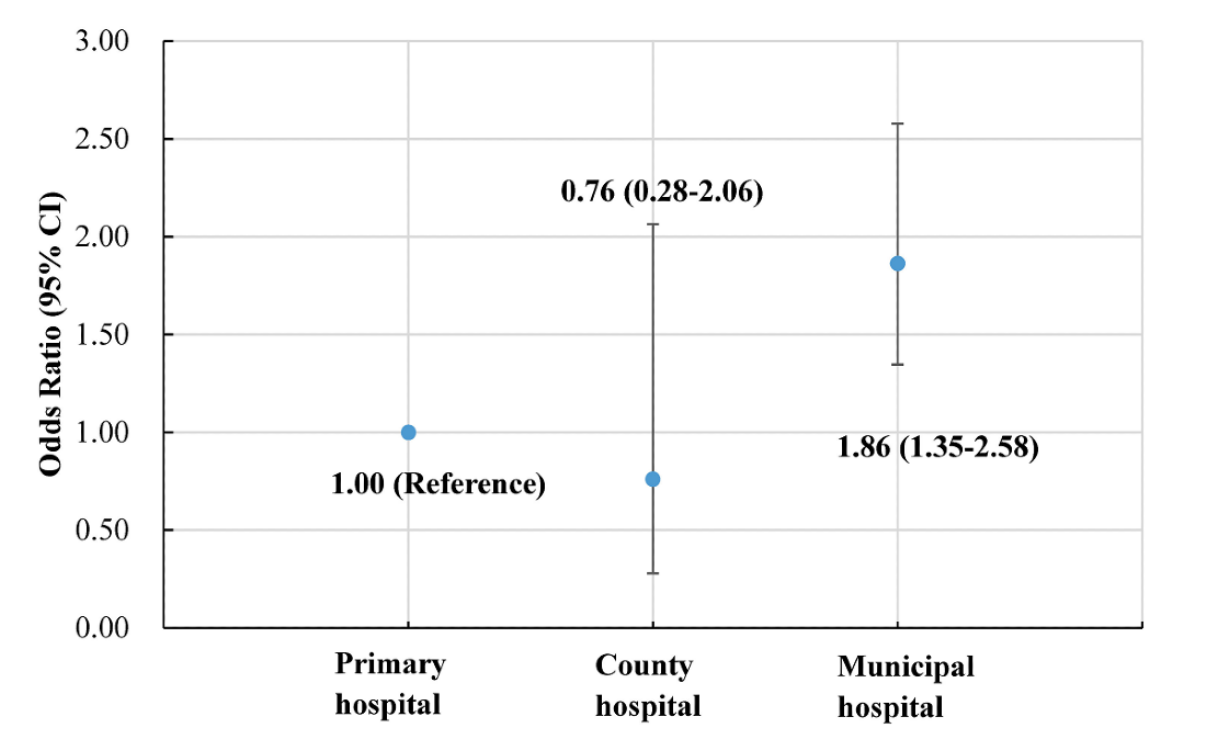
Figure 2. Odds ratio estimates based on Model